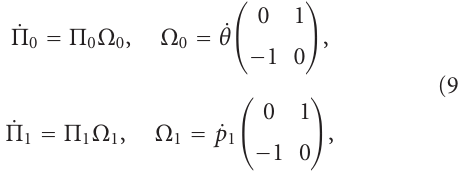
Figure 2: Definitions of local coordinates O m - XY for the object and O 1 - X 1 Y 1 for the fingertip.